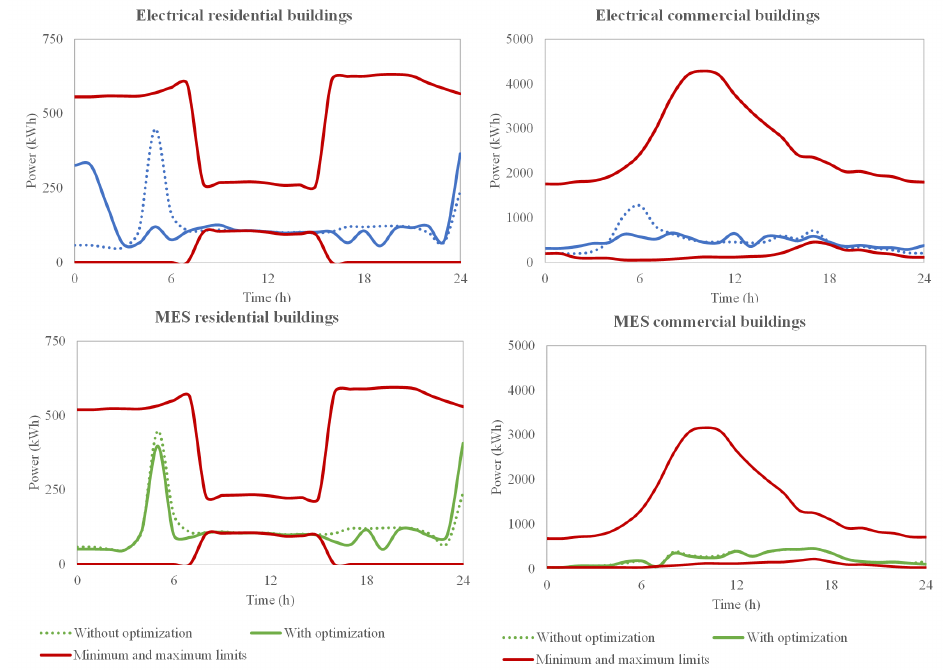
Figure 13. Total flexibility offered by residential and commercial buildings.